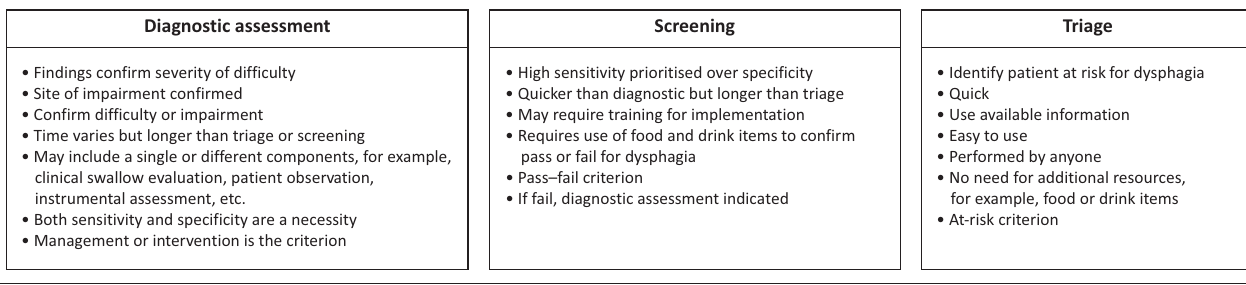
FIGURE 1: Considerations for clinical-decision making when choosing among diagnostic assessment versus screening versus